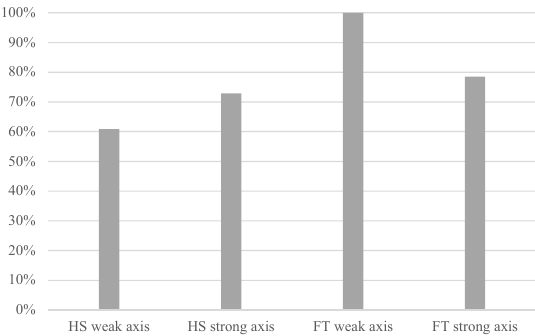
Fig. 12 Relative dispersion 5 %-fractile of four-point bending tests of Laufs (Laufs